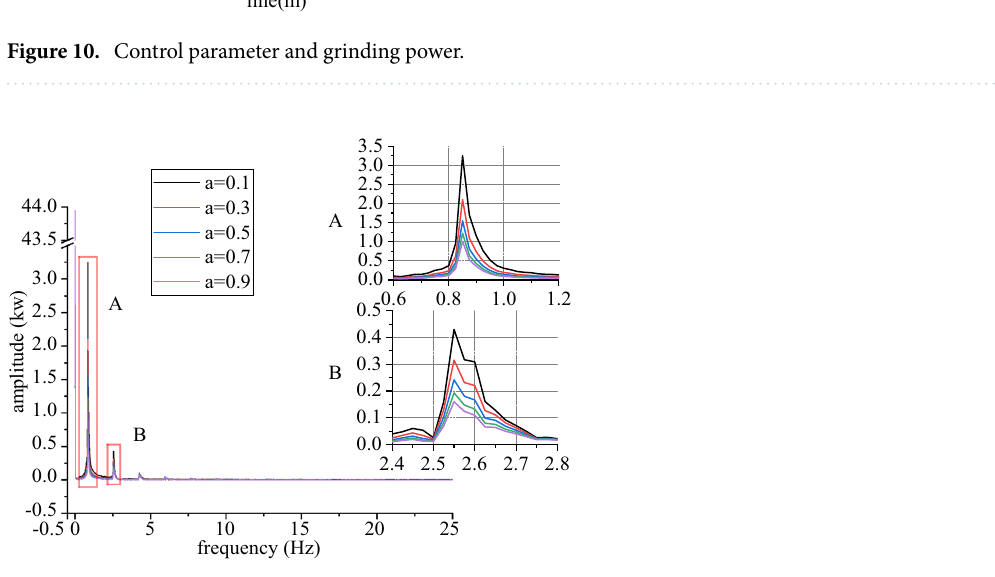
Figure 11. Spectrum characteristics of grinding